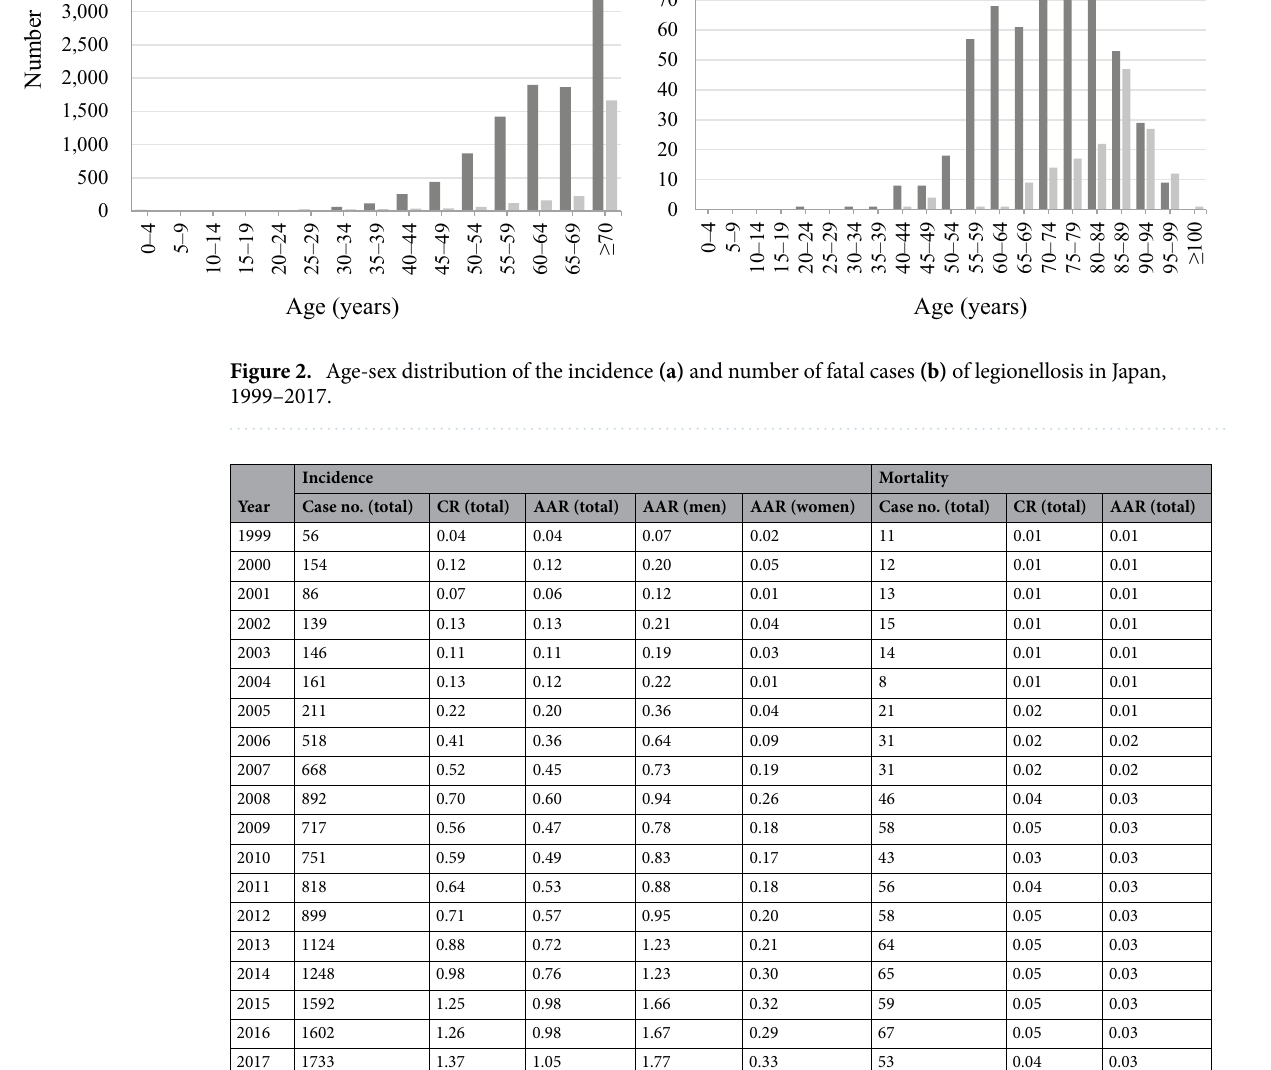
Table 1. Numbers, crude rates (CR), and age-adjusted rates (AAR) of incidence and mortality of legionellosis per 100,000 population in Japan, 1999–2017.